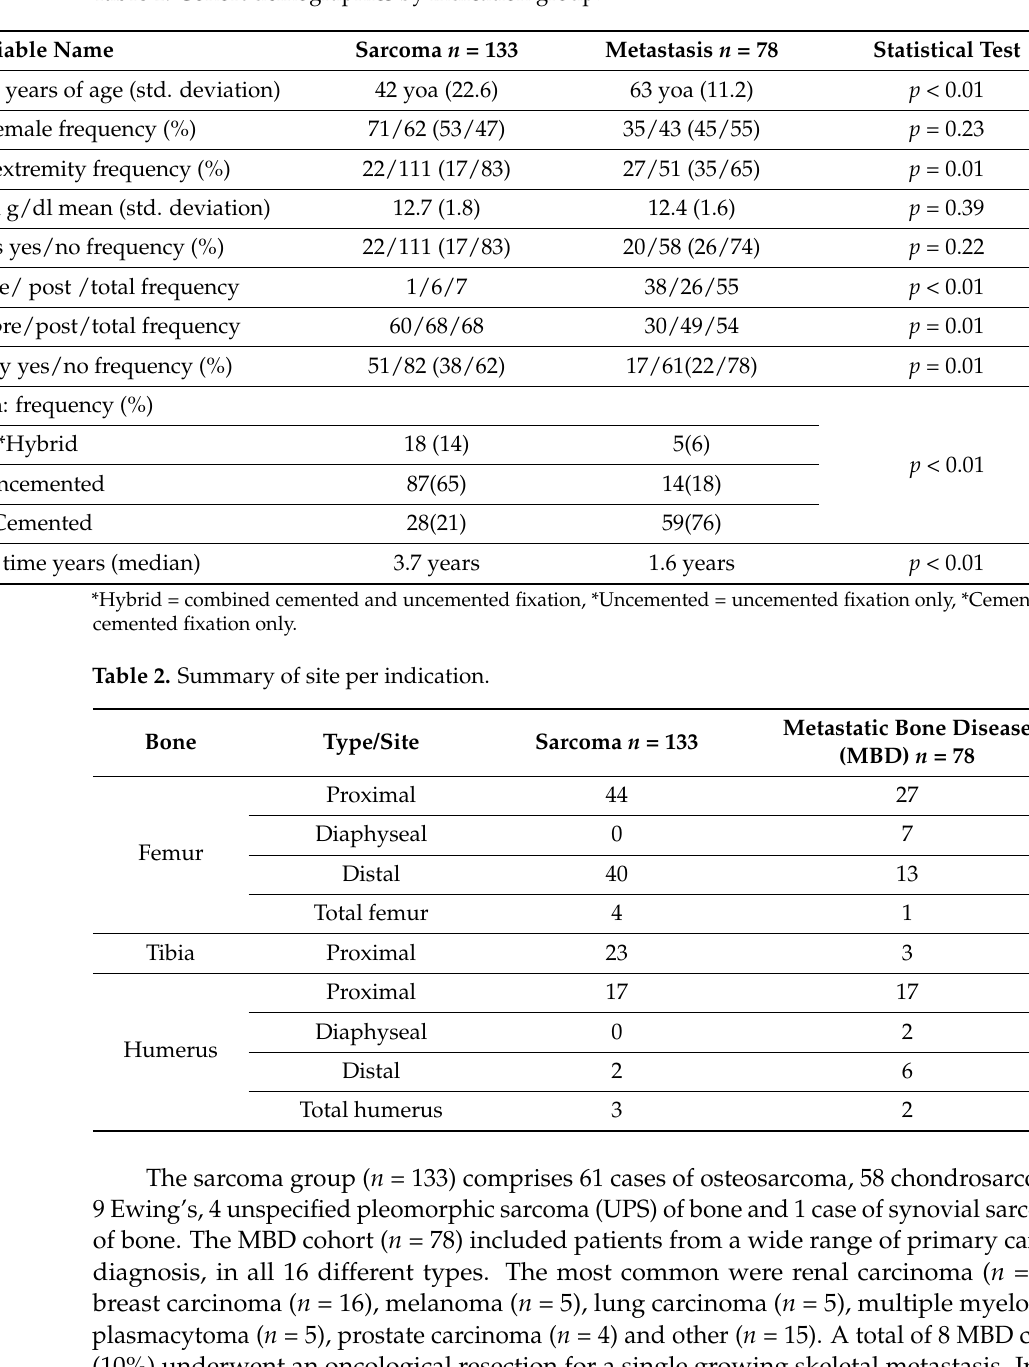
Table 1. Cohort demographics by indication group.